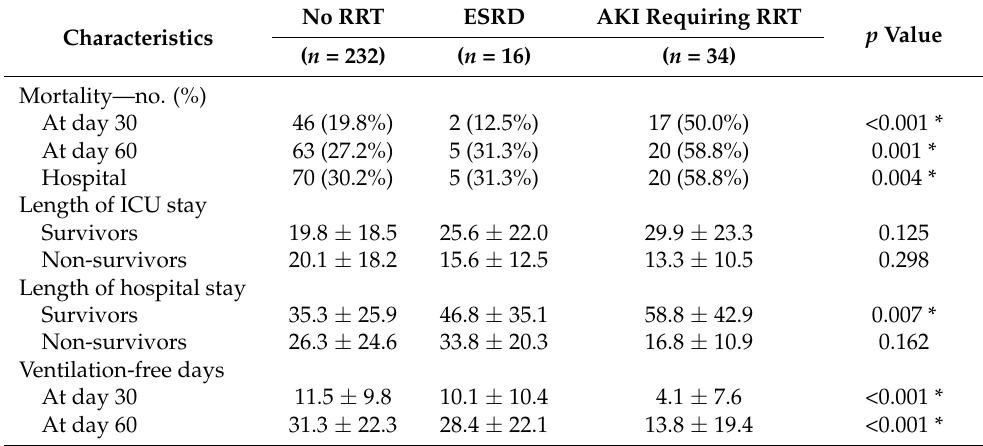
Table 3. Clinical outcome.